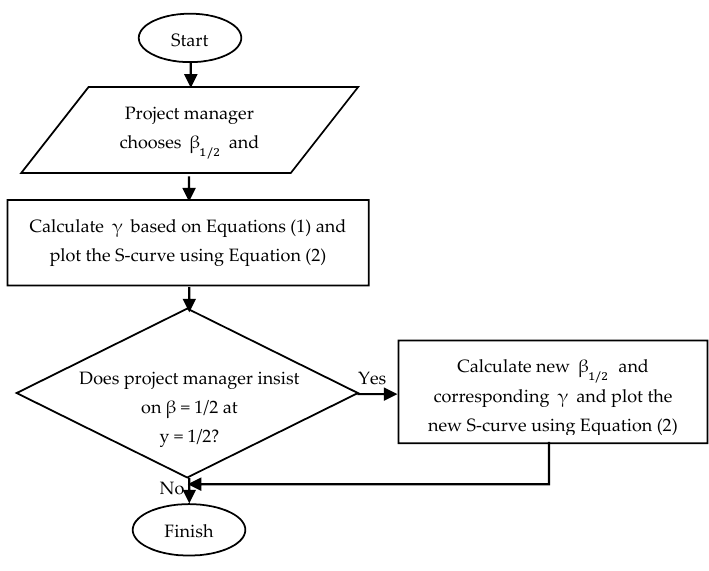
Figure 4. S-curve technique flowchart.